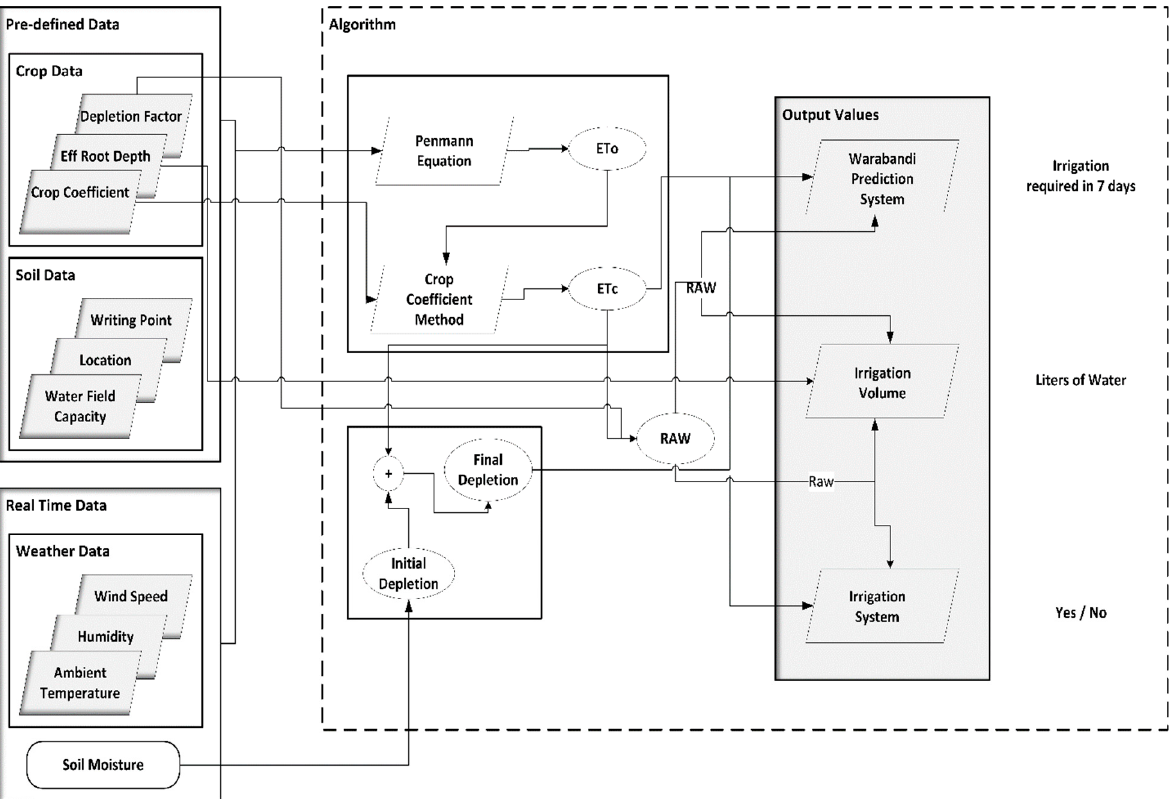
Figure 7. Irrigation Calculation Algorithm.